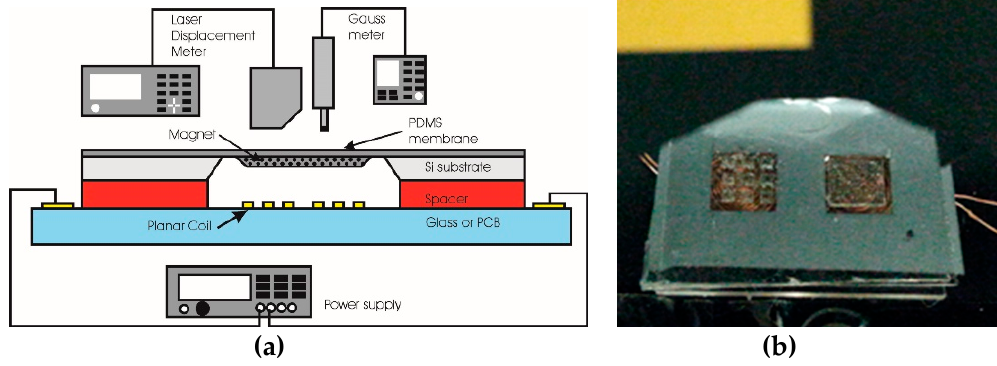
Figure 4. Schematic setup for the measurement of actuator membrane displacement ( a ) and the photograph of the fabricated actuator under test ( b ).